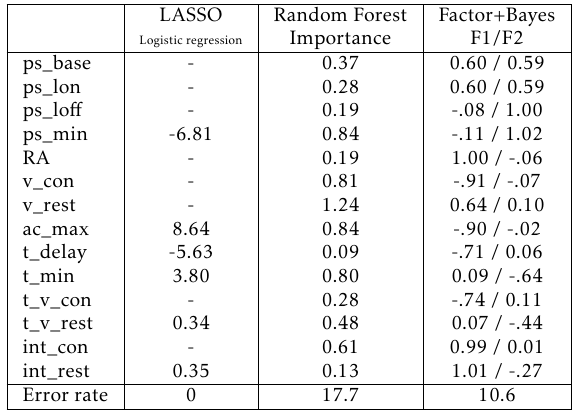
Table 7. Comparison of weights of variables (b100